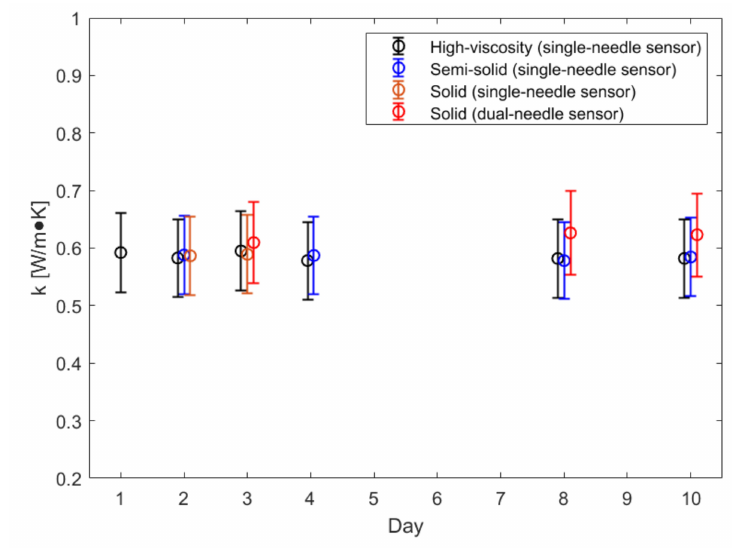
Figure 2. Thermal conductivity of the high-viscosity, semi-solid and solid phantom measured with the single-needle sensor and with the dual-needle sensor over time.